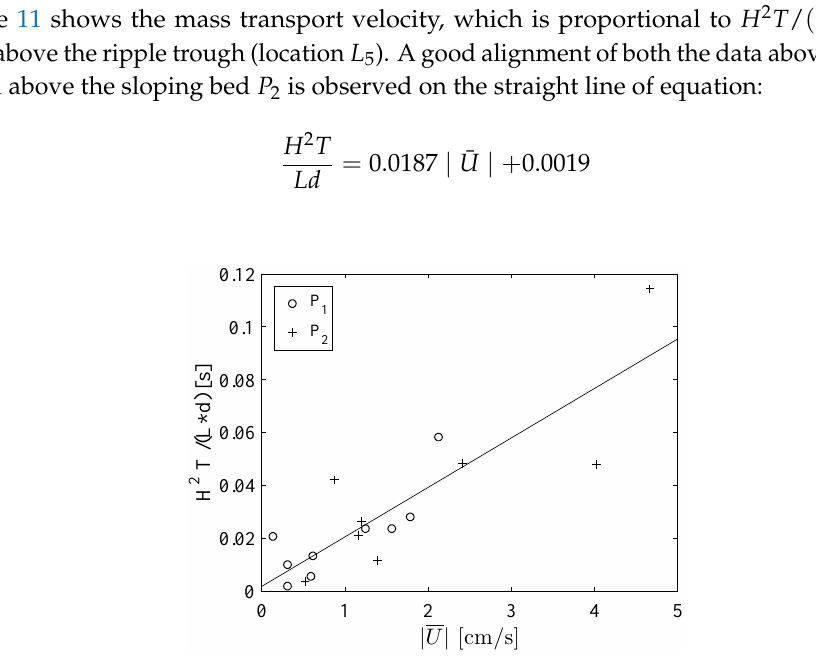
Figure 11. Mass transport velocity at location L 5